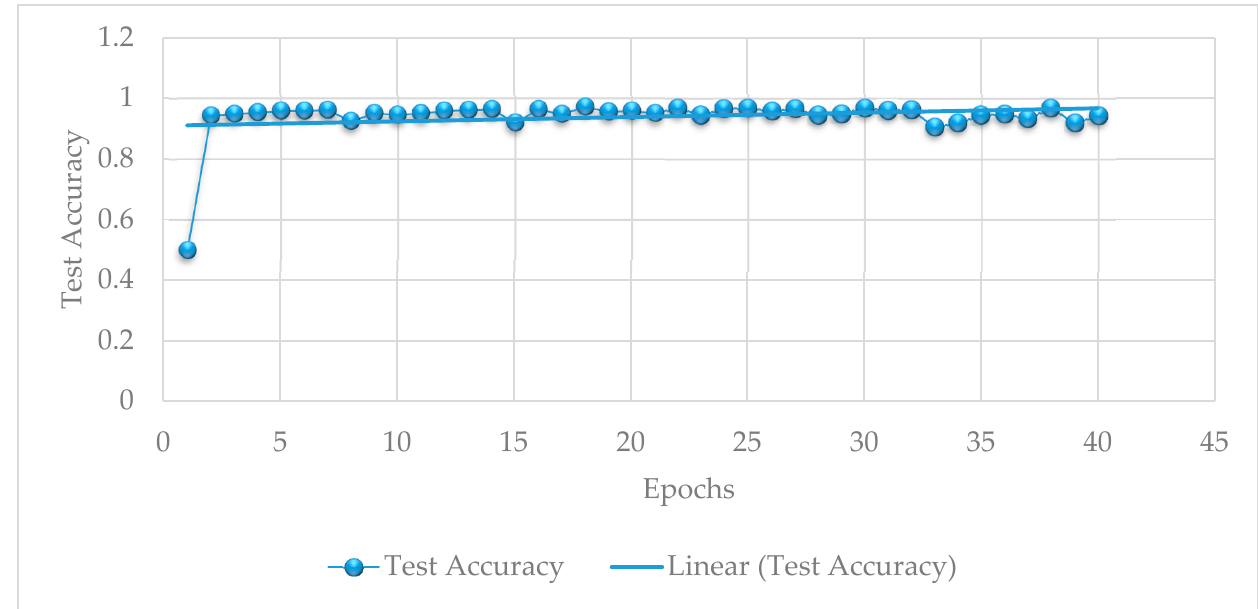
Figure 9. Graph showing train loss vs. epoch characteristics.